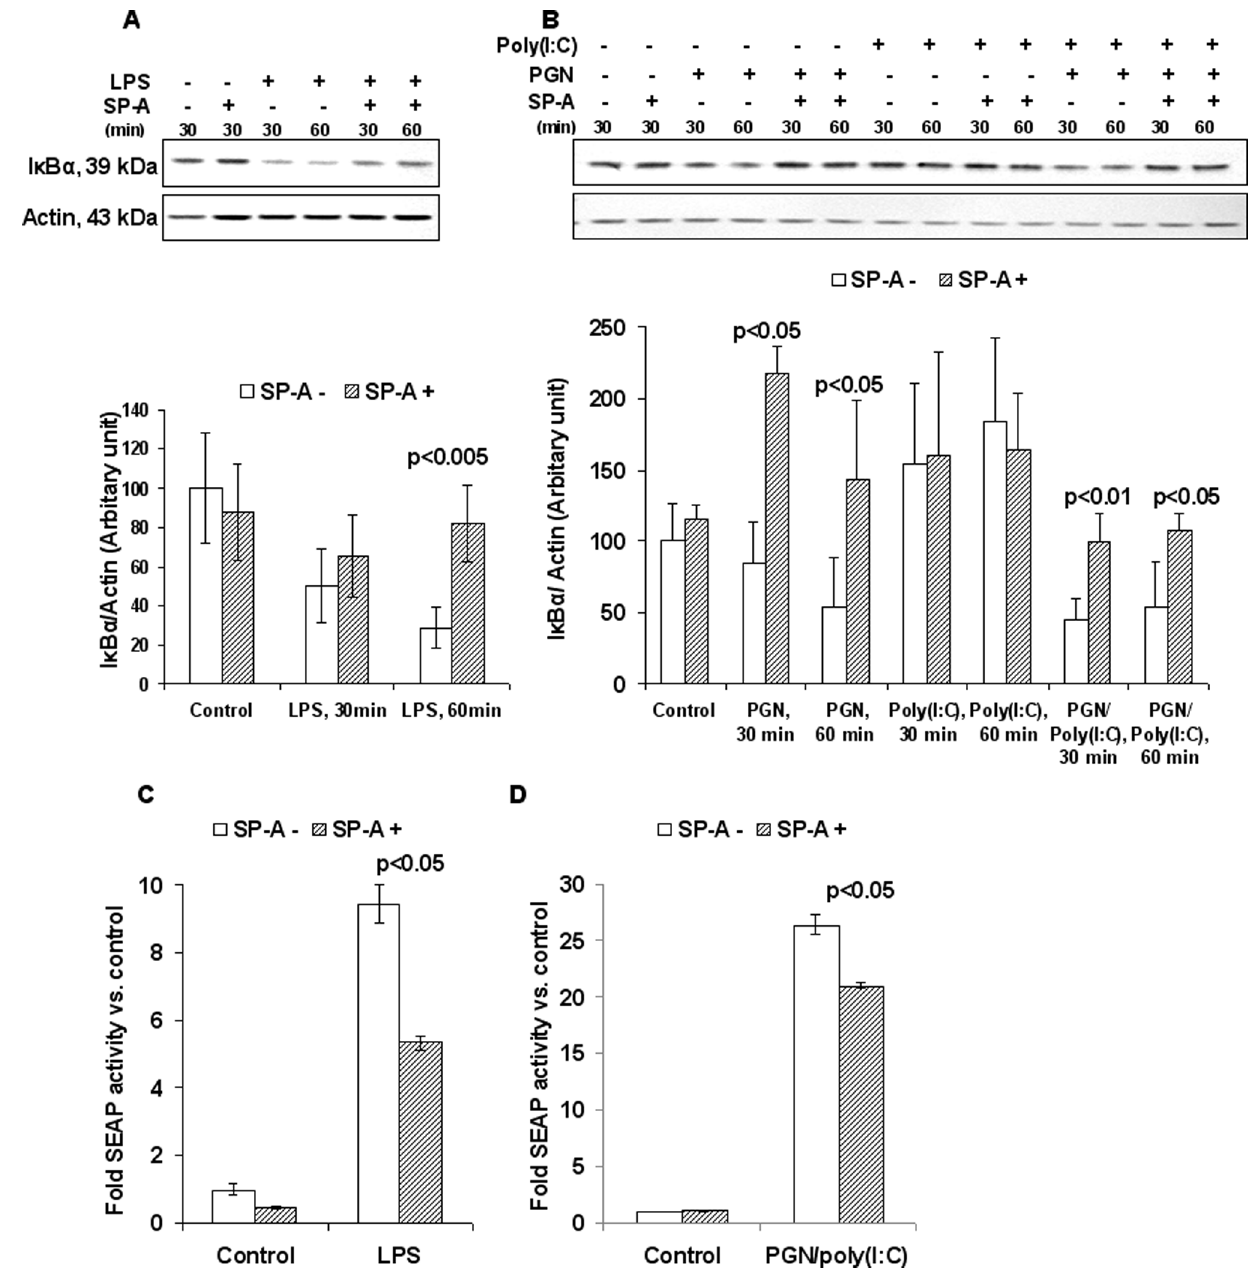
Figure 4. SP-A suppresses the NF- k B signaling pathway. A and B : Effect of SP-A on degradation of I k B a in macrophages stimulated with TLR ligands. Western blots (upper panels) and densitometric analysis (lower panels) of the effect of SP-A on levels of I k B a following treatment of RAW264.7 cells with either LPS (A) or PGN + poly(I:C) (B). Actin is used as a loading control. Representative blots of 2 independent experiments, each with duplicate sets, are shown. Values for control were set to 100 for densitometric analysis. C and D : SP-A attenuates TLR ligand-induced NF- k B activity in a mouse macrophage reporter cell line. NF- k B reporter gene assay in RAW-Blue TM cells showing the effect of SP-A on LPS- (C) and PGN + poly(I:C)- (D) induced NF- k B activity. Depicted is a representative figure from three repeat experiments. n=3 replicates per condition per experiment. P values were calculated by t-test and compare exposures with and without SP-A. Error bars=standard deviation.